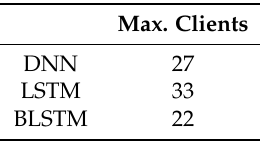
Table 6. Comparison of the multichannel performance of the Korean online ASR systems employing DNN-, LSTM-, and BLSTM AMs for the test set. The evaluation metric is the maximum number of concurrent clients where an ASR system can be performed in real